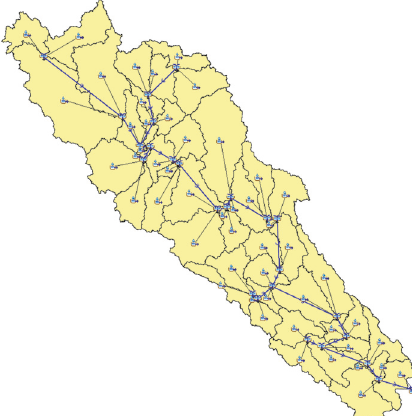
Figure 2: The schematic diagram of GRB with hydrologic elements (subbasins, reaches, junctions, and flow direction) delineated by